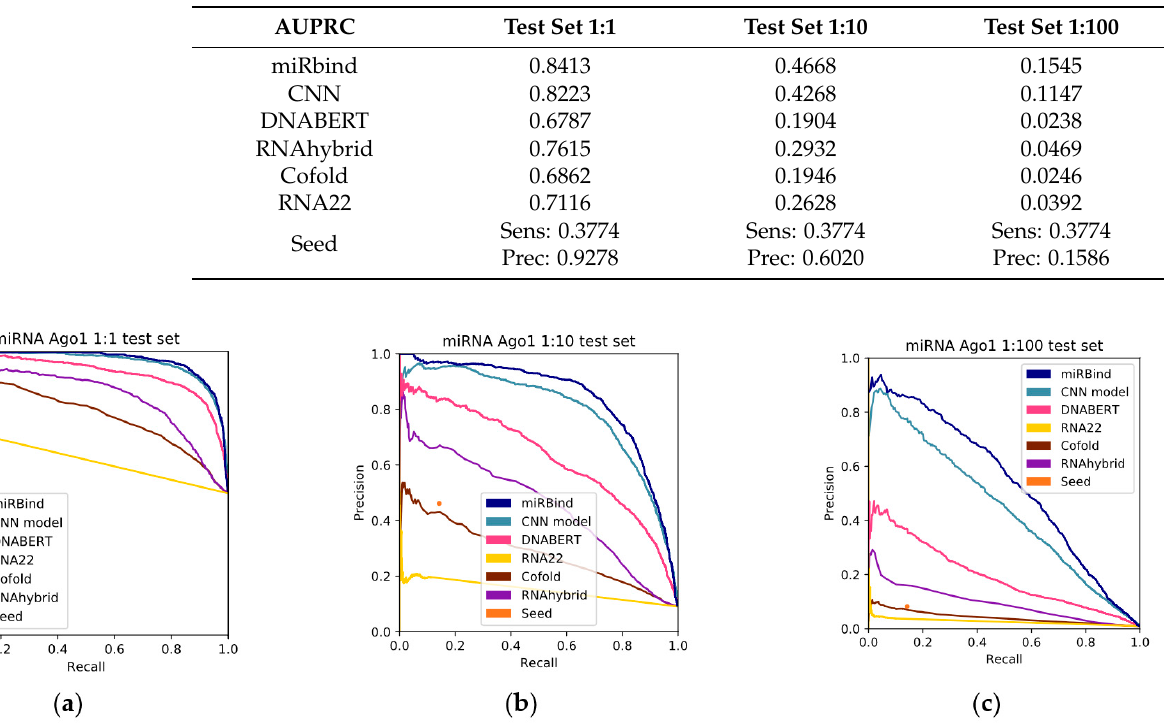
Figure 2. Precision-recall curves for all the methods, tested against ( a ) 1:1, ( b ) 1:10, and ( c ) 1:100 left-out test sets.